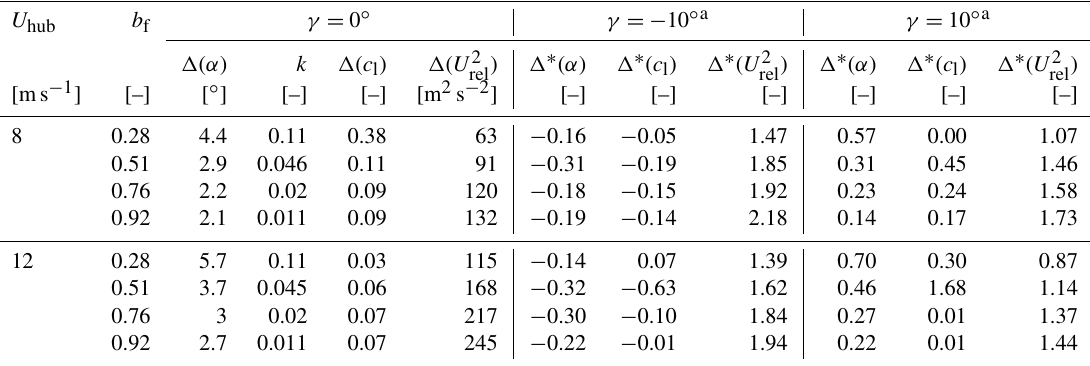
a (cid:49) ∗ denotes the relative difference in range of the argument, with respect to the same quantity at 0 ◦ yaw